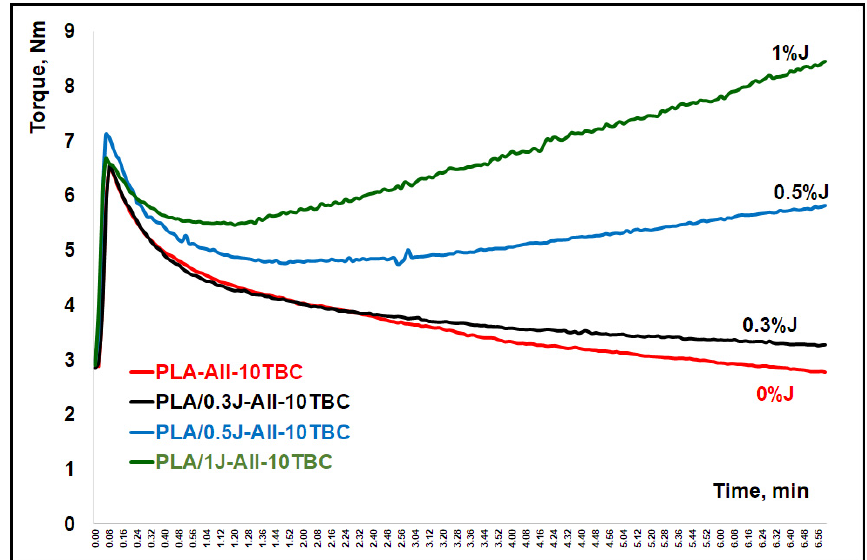
Figure 12. Evolution of mechanical torque during melt mixing of plasticized composites (PLA–AII–10TBC) with different loadings of Joncryl (J).